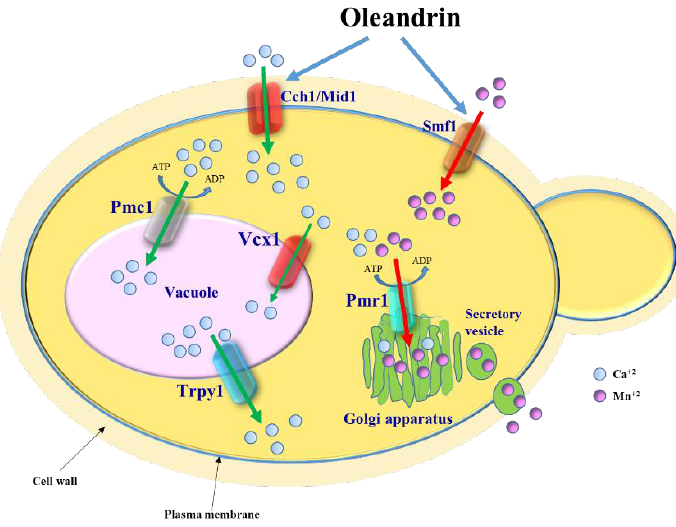
Figure 5. Model depicting the effect of oleandrin on S. cerevisiae cells. Oleandrin stimulates Ca 2+ influx via the Cch1/Mid1 channel and Mn 2+ uptake via the Smf11 transporter. Excess of [Ca 2+ ] cyt is transported into the vacuole via the Pmc1 ATPase pump and Vcx1 transporter. Cells lacking Pmc1 become oleandrin-hypersensitive due to a delay in restoring the low level of [Ca 2+ ] cyt (Figure 3b, orange line). The excess of Mn 2+ taken up via Smf1 in response to oleandrin exposure is removed by the Ca 2+ /Mn 2+ -ATPase pump Pmr1 which transports the excess Mn 2+ to the Golgi apparatus to be further secreted from the cell via secretory vesicles.